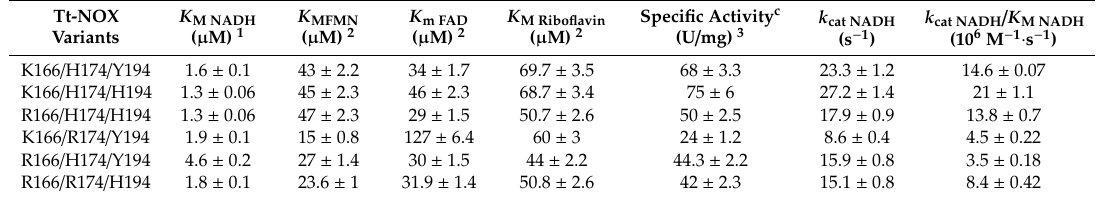
Table 2. Apparent kinetic parameters of the purified Tt27-NOX variants calculated at pH 7 and 25 ◦ C.